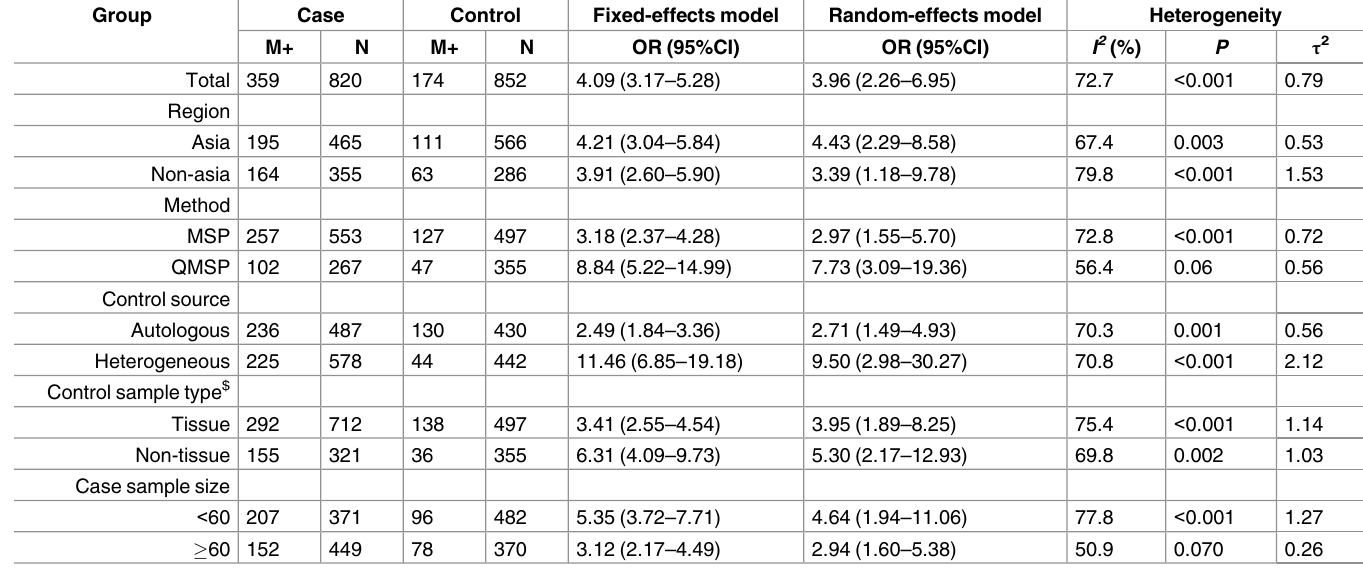
Table 4. Summaryof the subgroup analysisin the meta-analysis of DAPK promoter methylation and HNSCC.